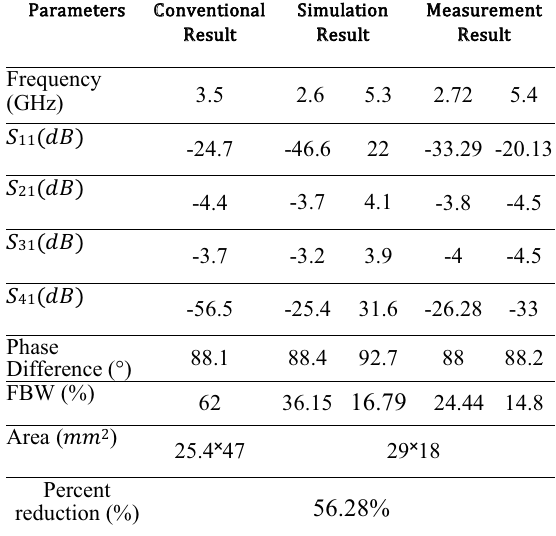
Fig.11. The proposed dual-band patch coupler simulation and measurement phase Table 3. Comparison between the conventional and the proposed model of the dual-band patch